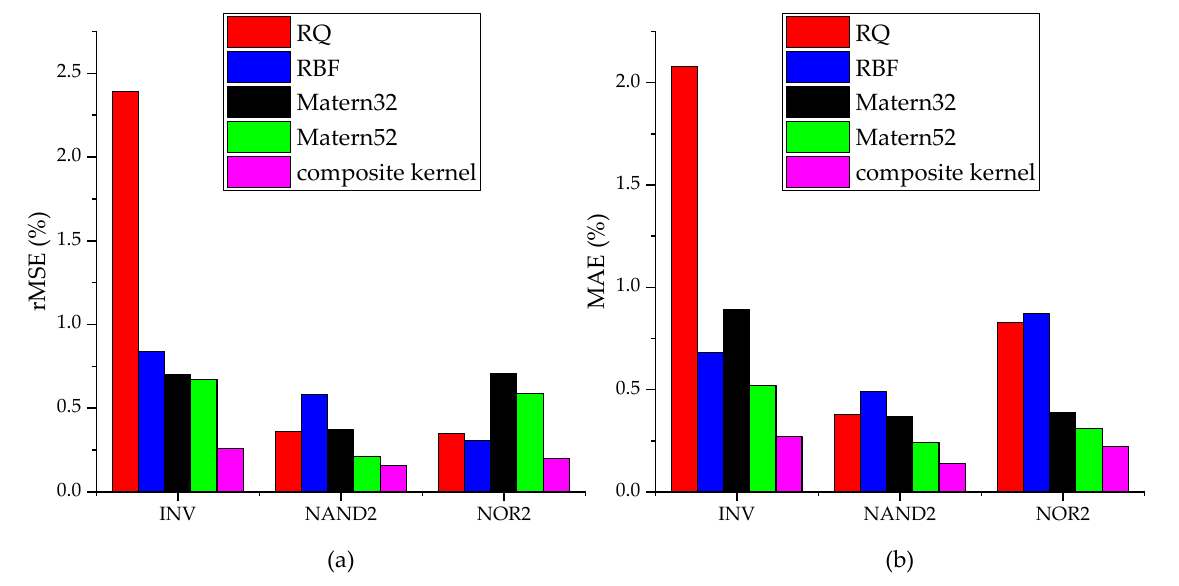
Figure 4. Accuracy comparation between different GPR kernel: ( a ) rMSE comparation; ( b ) MAE comparation.